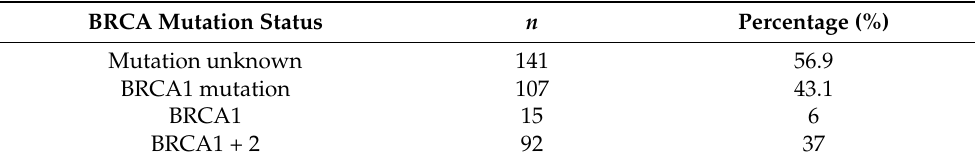
Table 1. BRCA mutation status of analyzed